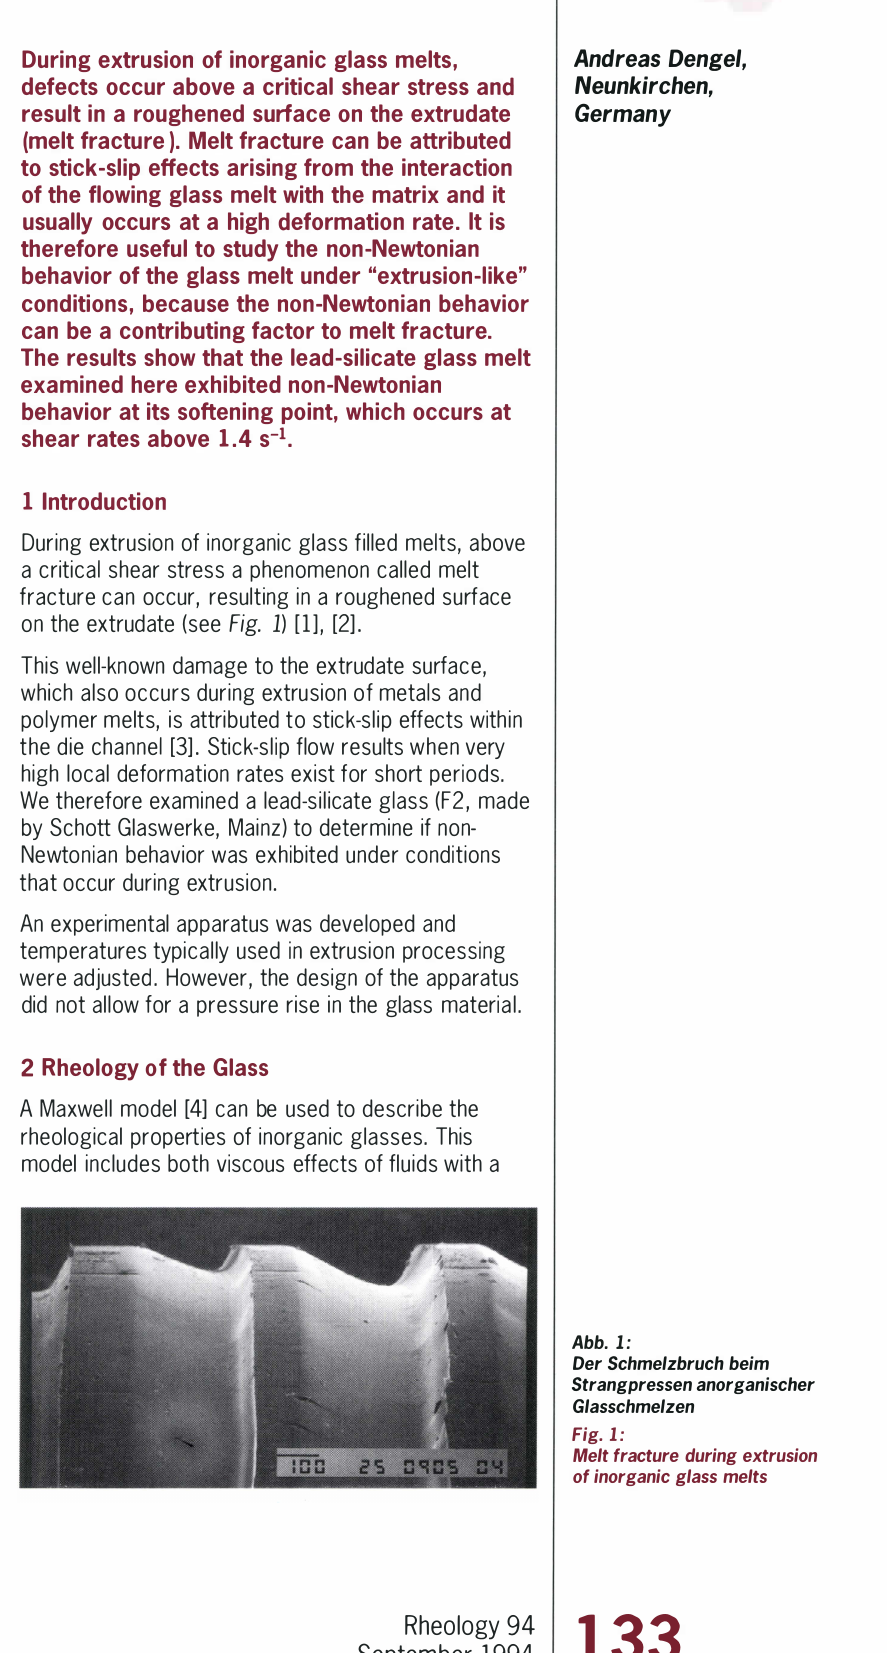
Fig. 1: Melt fracture during